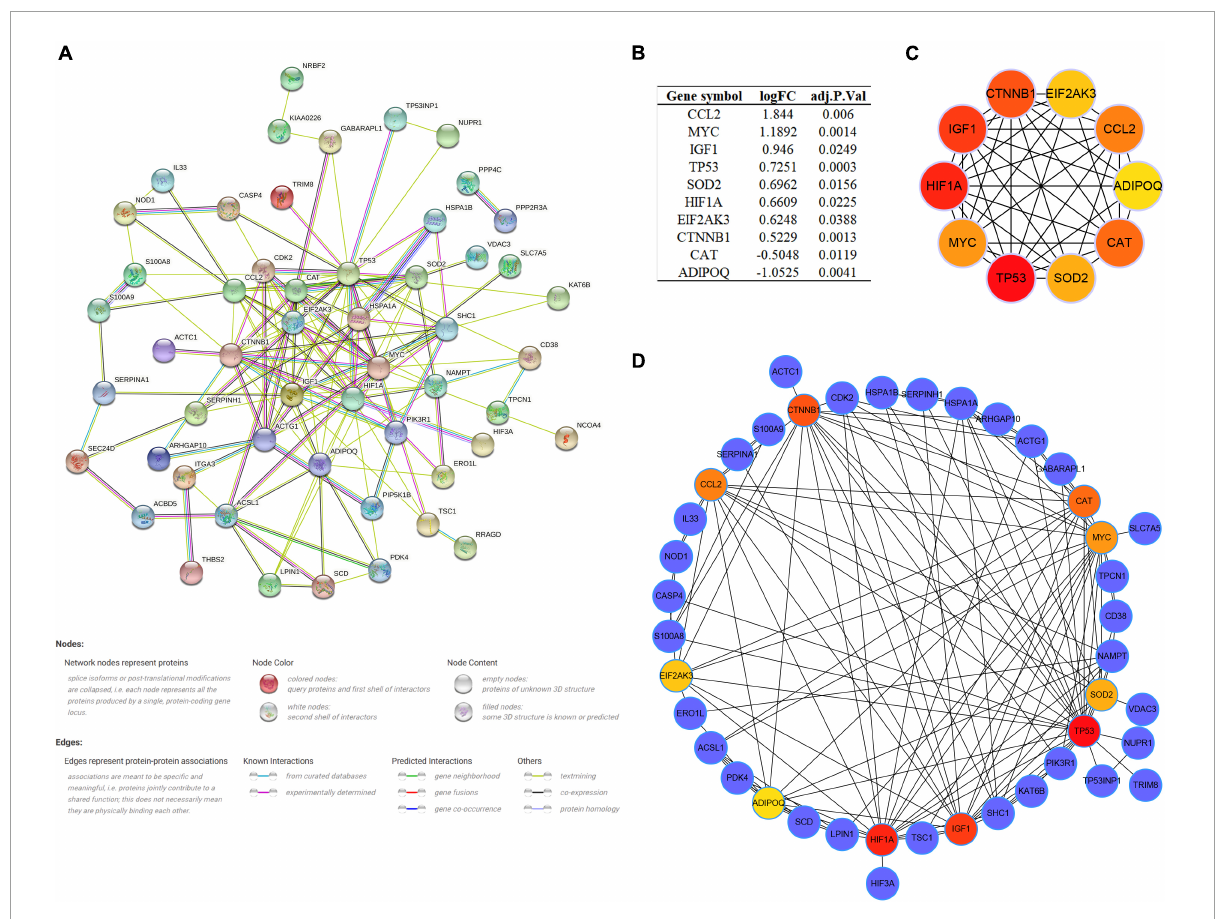
FIGURE5 Protein–protein interaction (PPI) network and identification of hub genes. (A) PPI network of all DEARGs constructed by STRING database, no connected dots were hidden. (B) The differential expression of hub genes in septic hearts from GSE79962. (C) Crosstalk between top 10 hub genes ranked by MCC algorithm, the deeper color of the dot means that the rank order of the hub gene is more advanced. (D) Crosstalk between top 10 hub genes ranked by MCC algorithm and other DEARGs. DEARG, differentially expressed autophagy-related